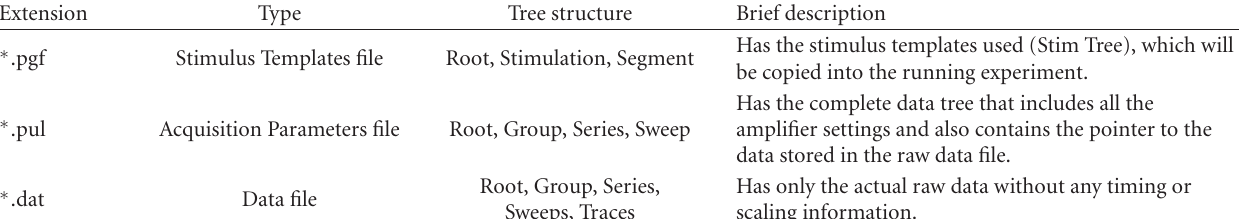
Table 1: Brief description of the three main files in a PULSE experiment.